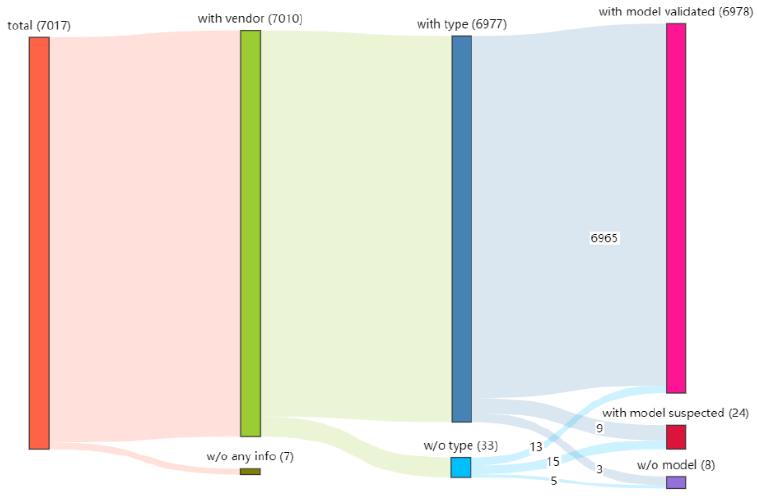
Figure 9. OCR-based identification results.